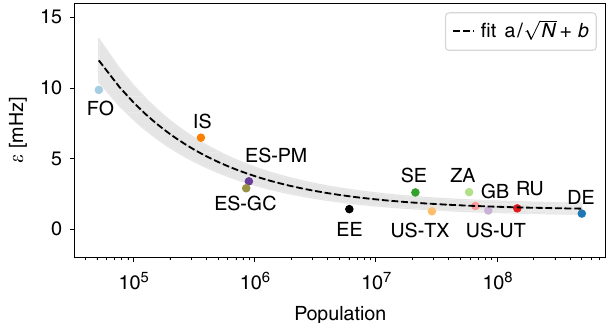
Fig. 3 The noise tends to decrease with an increasing size of the synchronous area until it saturates. We plot the extracted noise amplitude ϵ compared to the logarithm of the population in a given synchronous area. The population size serves as a proxy for the total generation and consumption of that area, as data on the size of the power grids is not commonly available. The shaded area is the SD of the ϵ